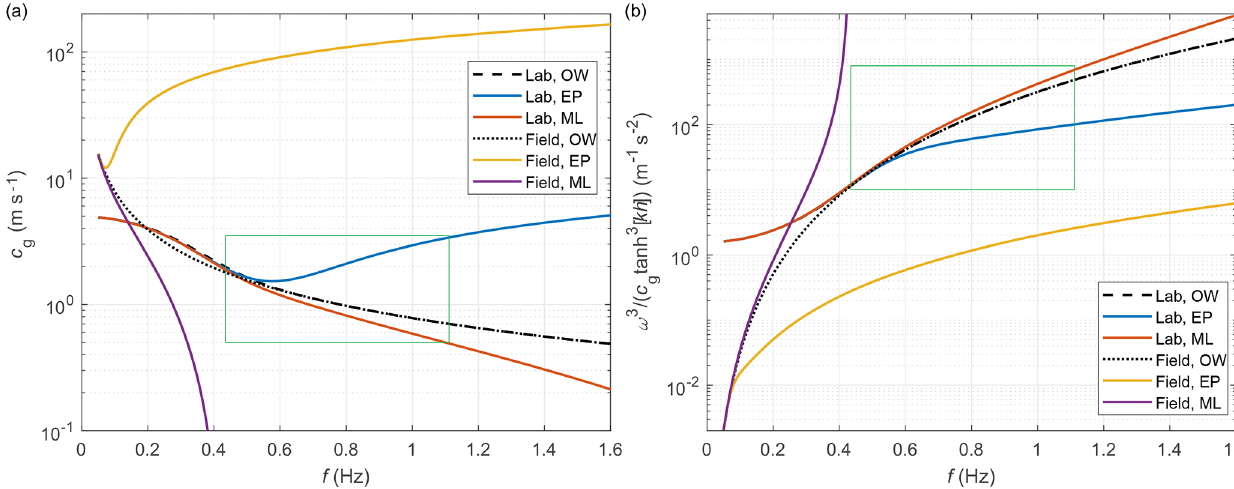
Figure 1. Group velocity c g (a) and the ratio ω 3 /(c g tanh 3 [ kh ] ) (b) versus wave frequency f = ω/( 2 π) , computed for thin laboratory ice (test series 3000 from the LS-WICE experiment analysed in Part 2) and for field conditions with h = 1000m, ρ w = 1025kgm − 3 , ρ i = 910kgm − 3 , E = 6 × 10 9 Pa, and h i = 1 . 5m. The corresponding open water solutions are shown in black (note that the two black curves overlap for f > 0 . 5Hz). Green rectangles mark regions covered by the LS-WICE experiment.